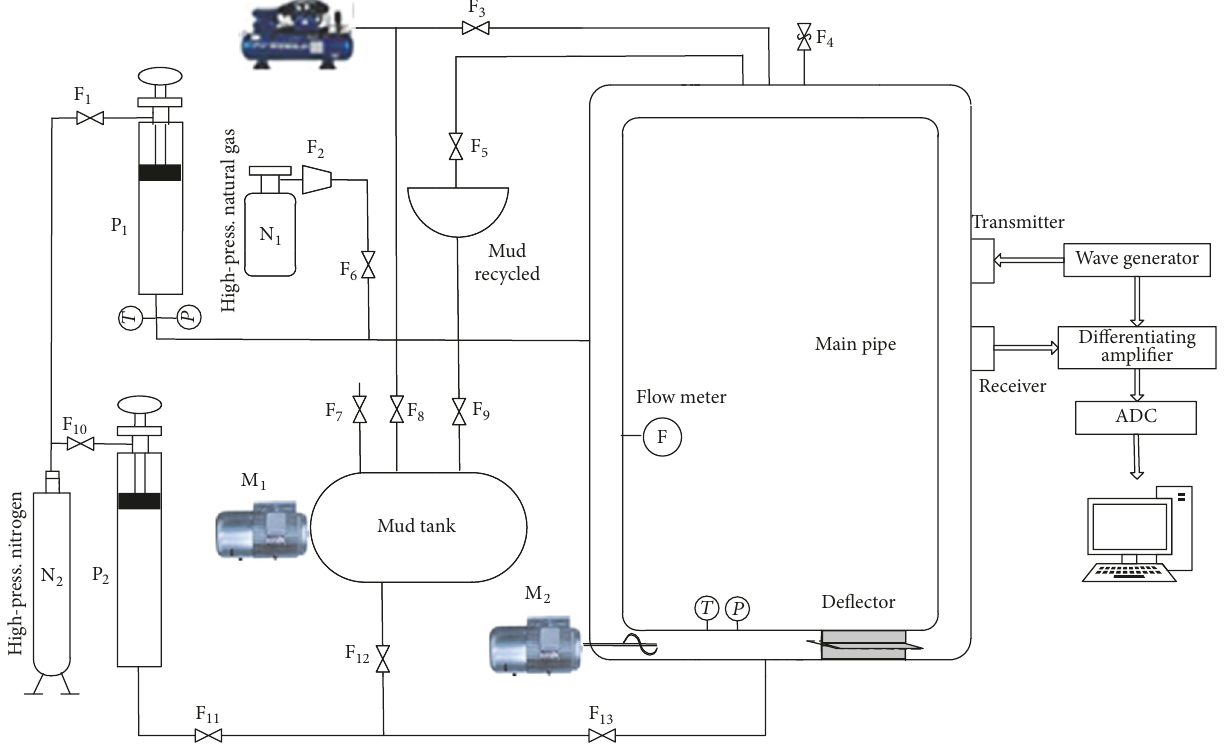
Figure 10: Schematic diagram of the experimental platform.